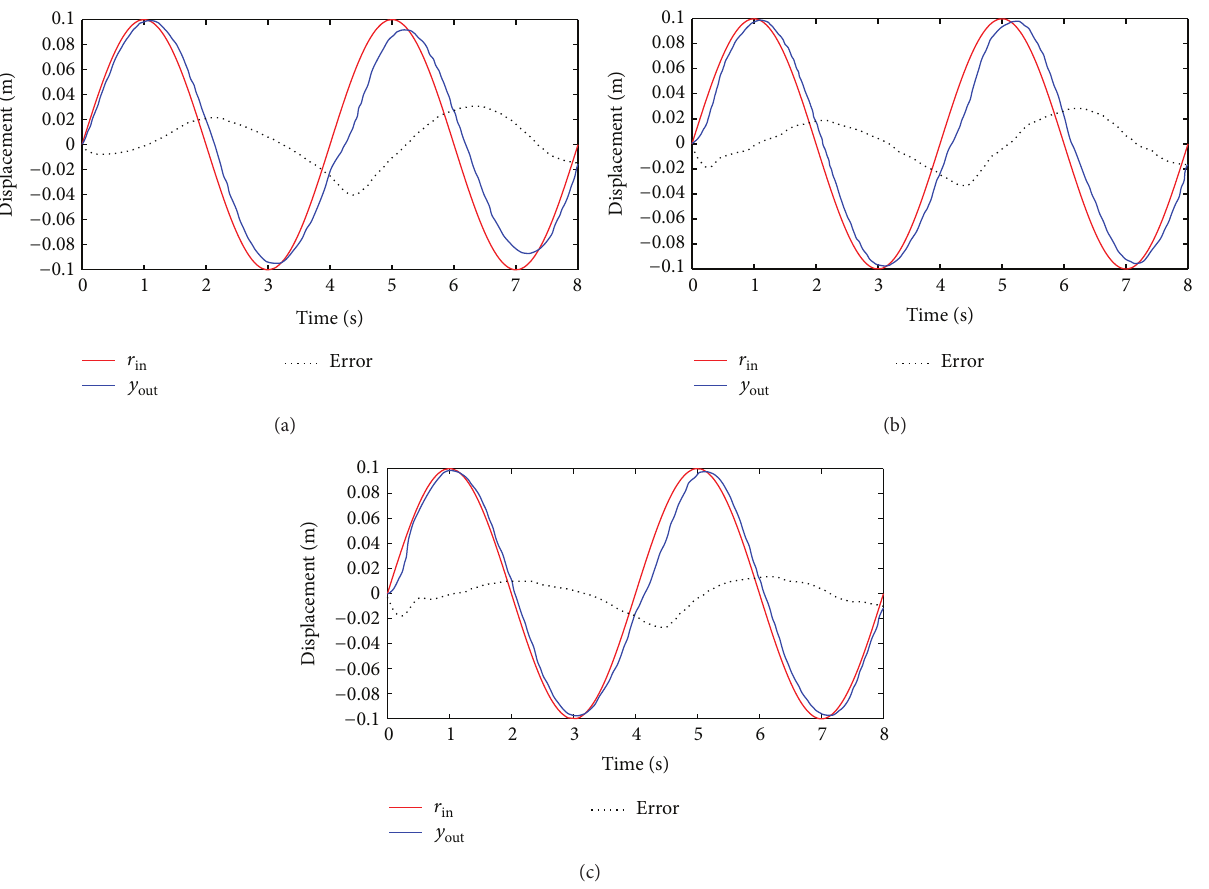
Figure 10: Experimental results for VCAHC of sine signal under variable load: (a) PID controller, (b) CMAC-PID controller, and (c) CMAC- PI 𝜆 D 𝜇 controller.